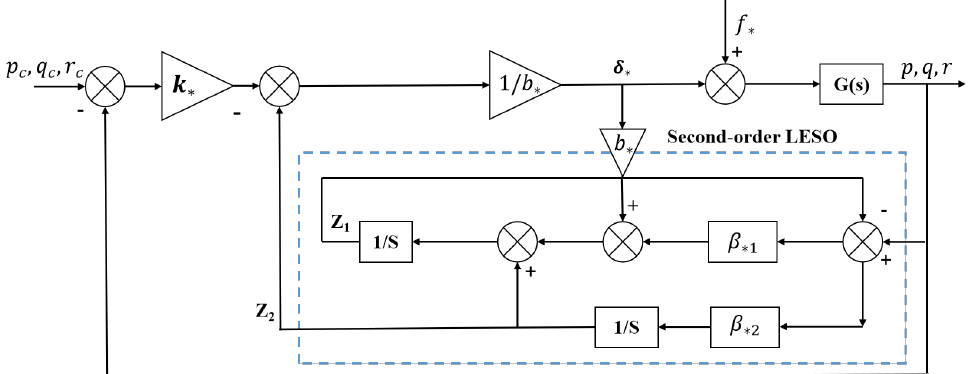
Figure 6. Complete control architecture. Cascaded ESO-based control schemes to handle the control stabilization.